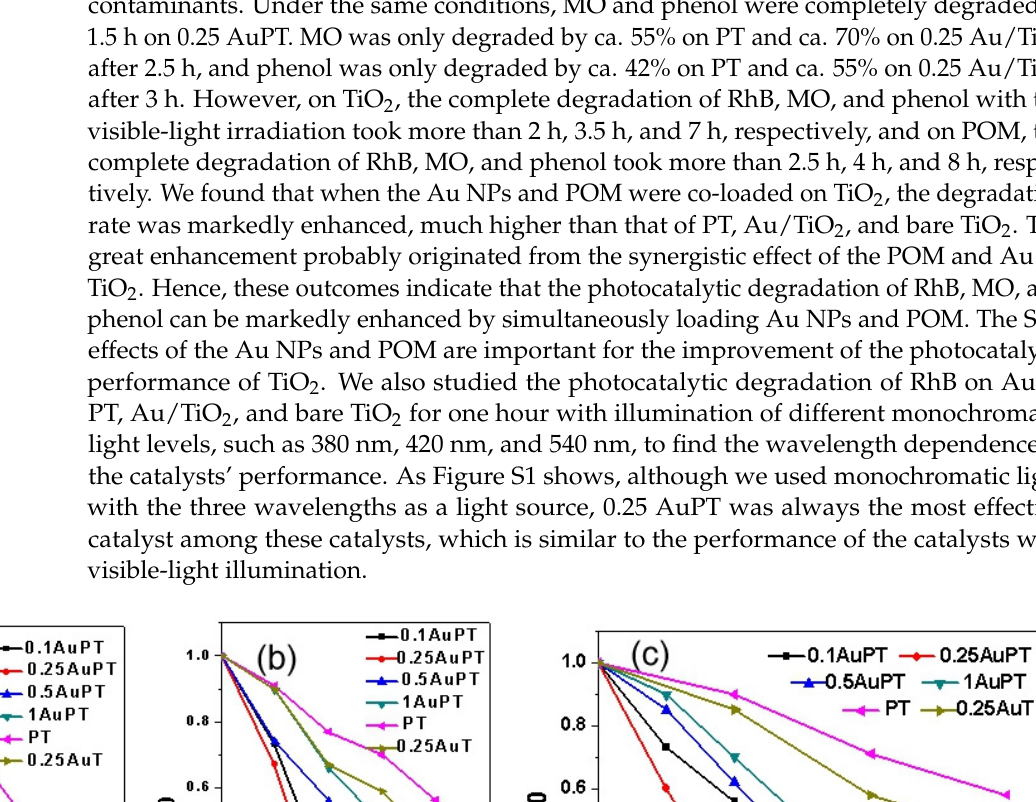
Figure 4. UV-visible diffuse reflectance spectra of POM and AuPT with different Au loadings.